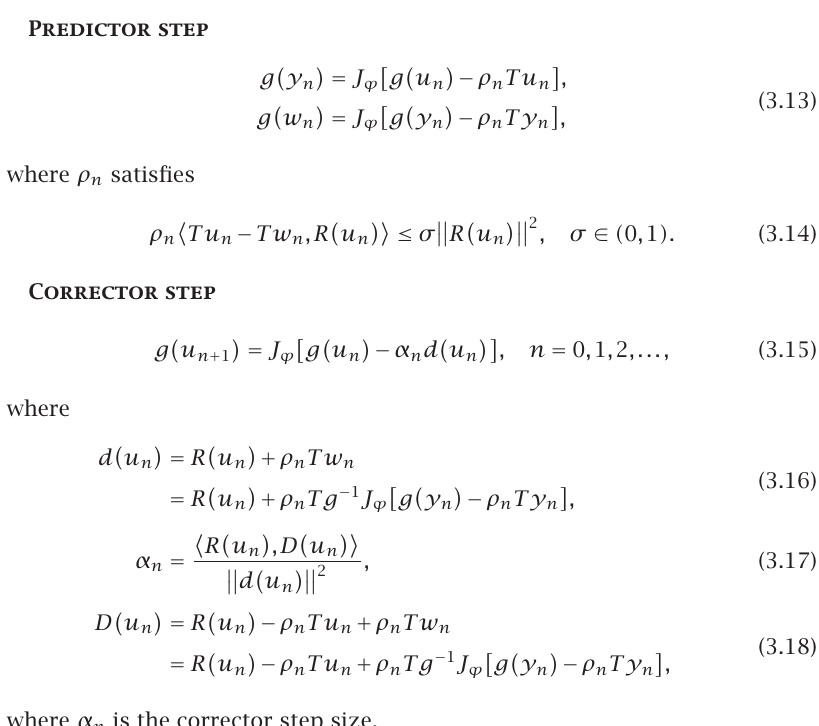
∈ H , compute the approximate solution 0